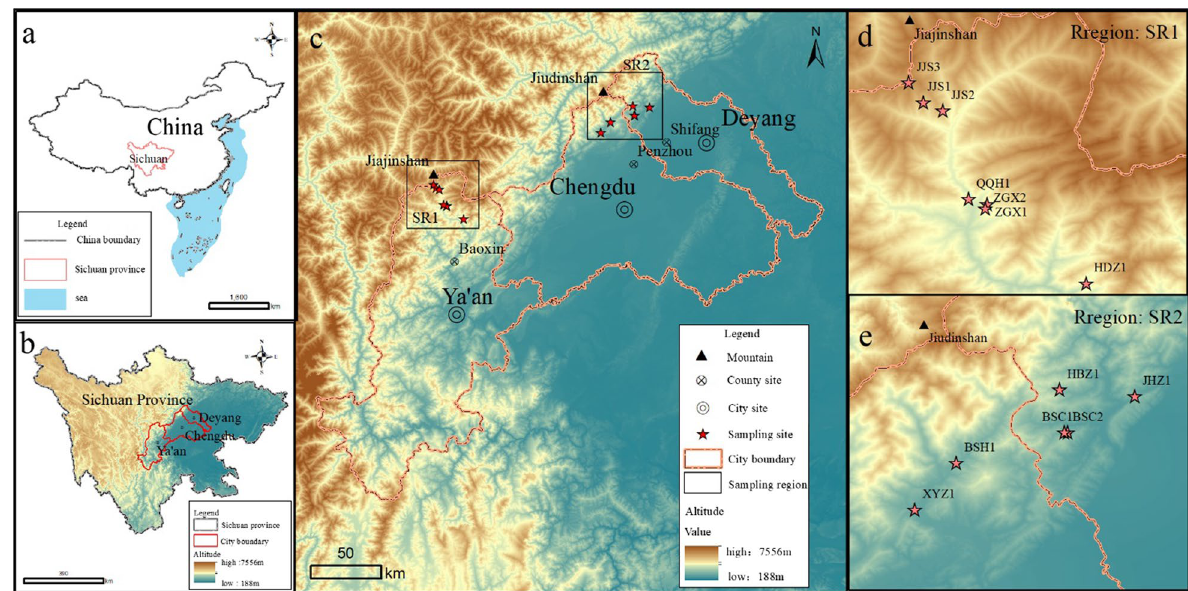
Fig. 1 Study regions and sampling sites lying in mountainous regions of west Sichuan,